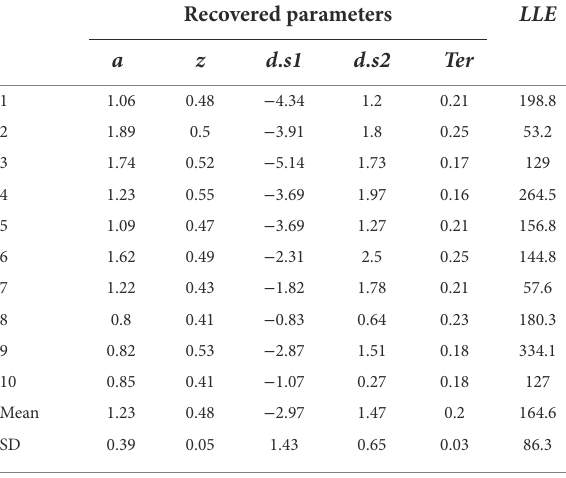
TABLE 5 Parameter recovery test: estimated parameters “recovered” from simulated